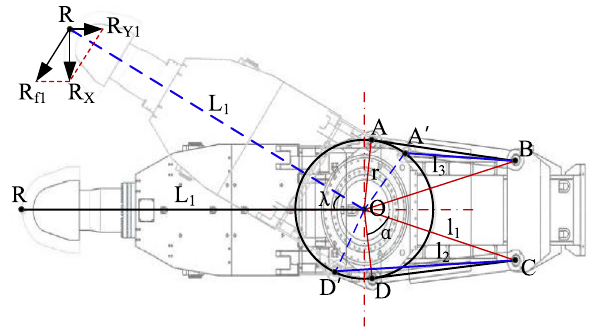
Fig. 4 Schematic diagram of horizontal swing process of the cut- ting arm